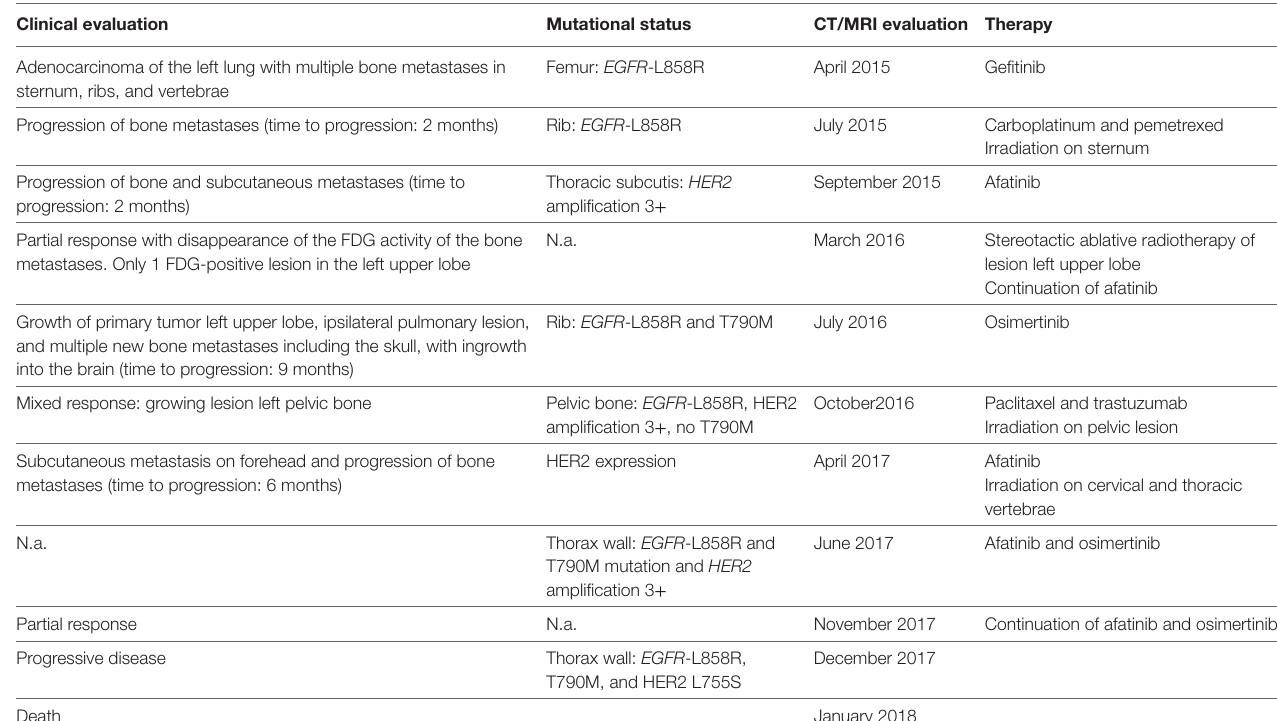
taBle 1 | Overview of clinical and pathological findings and subsequent therapeutic